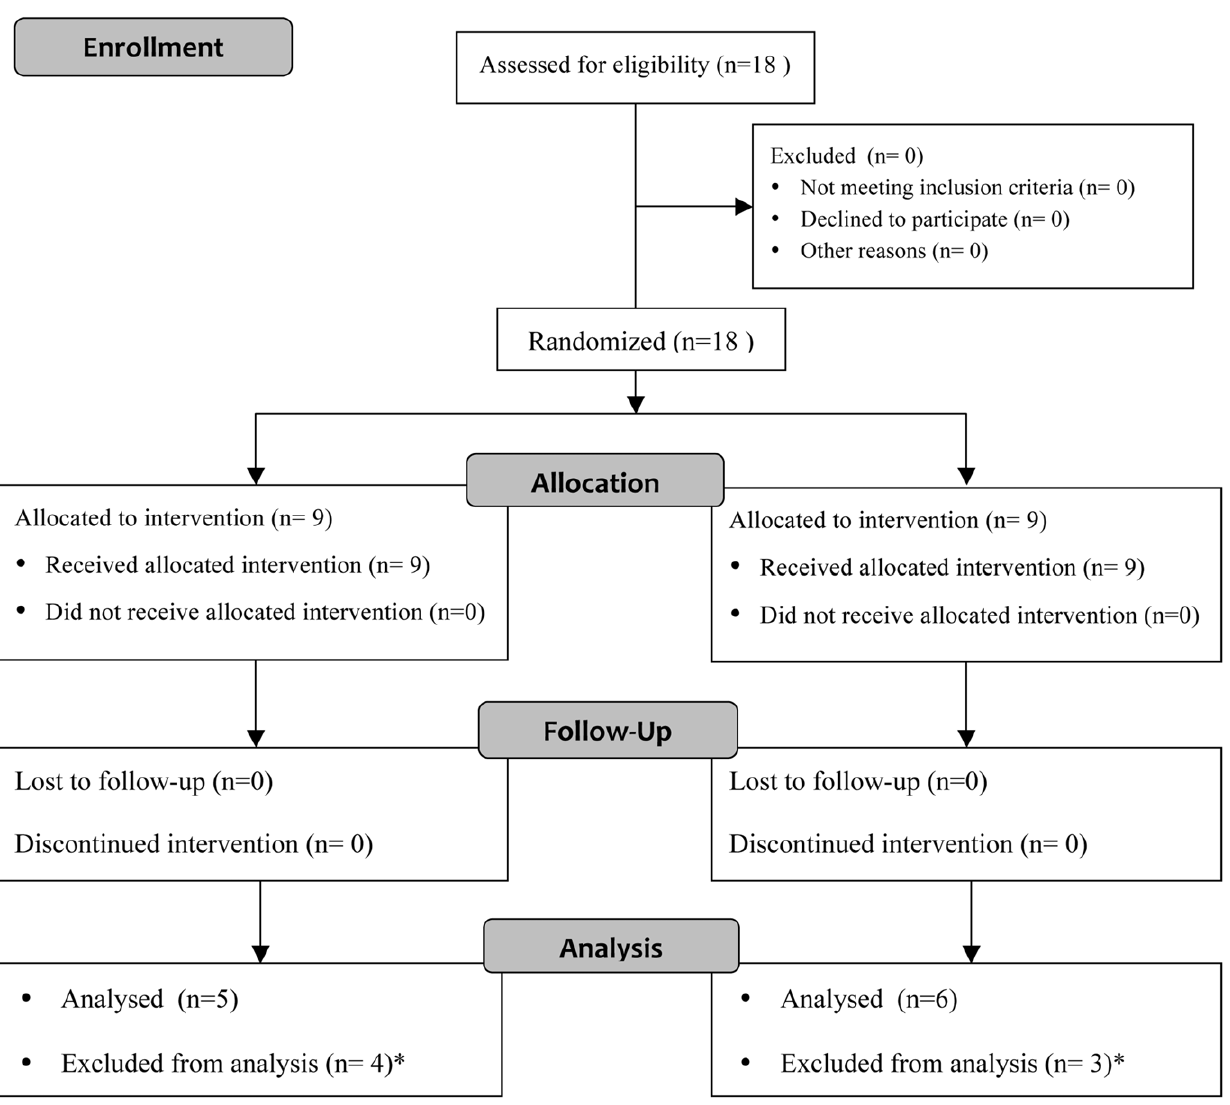
Figure 1. Flowchart of intervention assignment of HF patients. *Skeletal muscle biopsies were not taken from these patients, therefore, they were excluded from analysis.